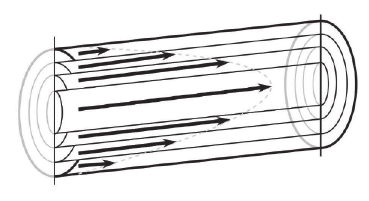
Figure 11 - Cross section showing the velocity vectors in a Poiseuille